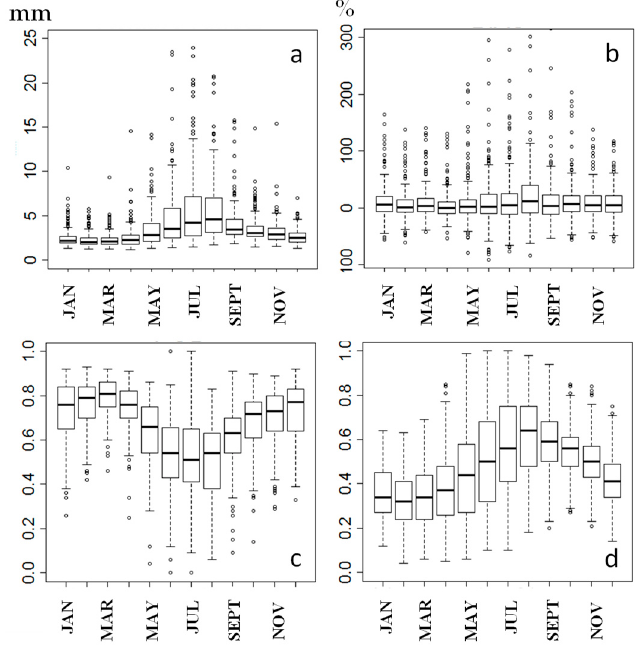
Figure 6. ( a ) Relative RMSE (in mm), ( b ) bias (in mm), ( c ) POD, and ( d ) FAR of 3B42, at daily time scale for each month, calculated from 2000 to 2013 at daily time scale.